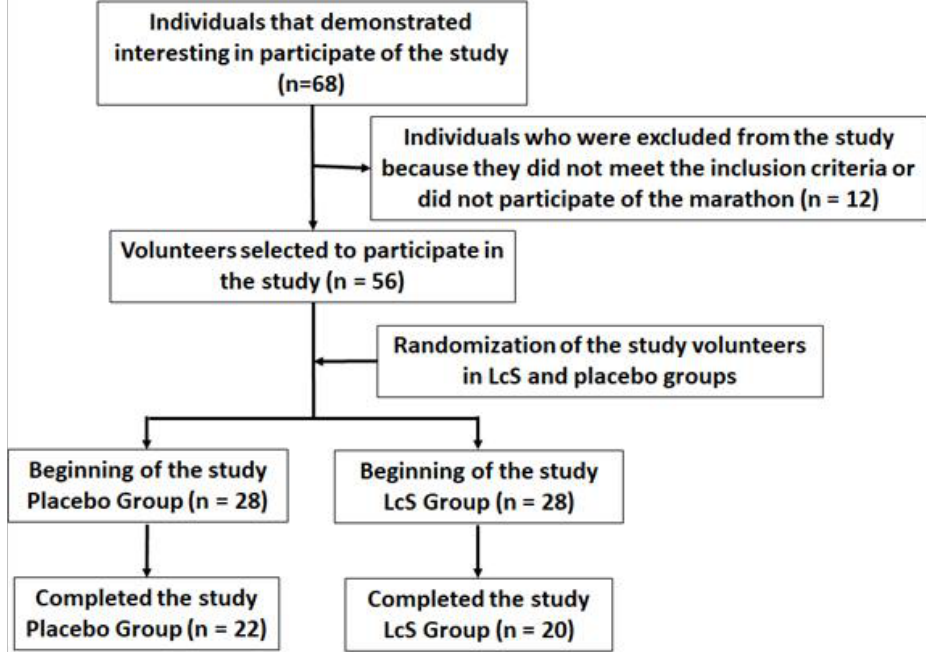
Figure 1. Flow diagram of the study.